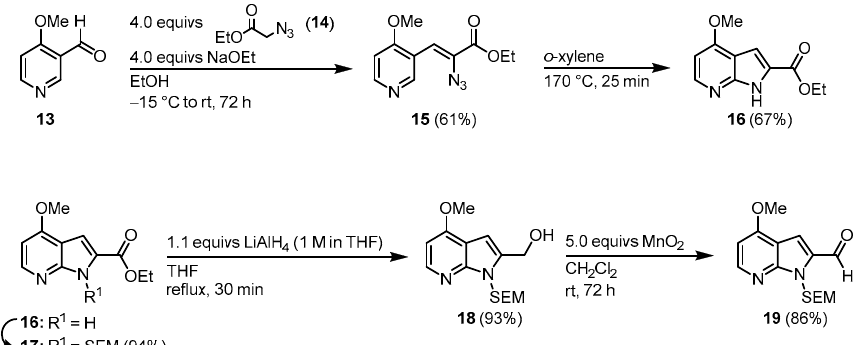
Figure 5. Synthesis of key intermediate azaindole 19 . Reaction conditions for a: first: 1.4 equivs NaH, DMF, rt, 45 min. Then: 1.4 equivs SEM-Cl, rt, 12 h [44].